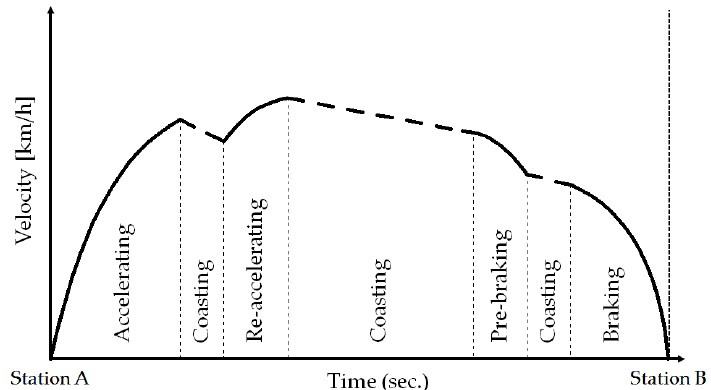
Figure 1. Standard operating curve between two stations.